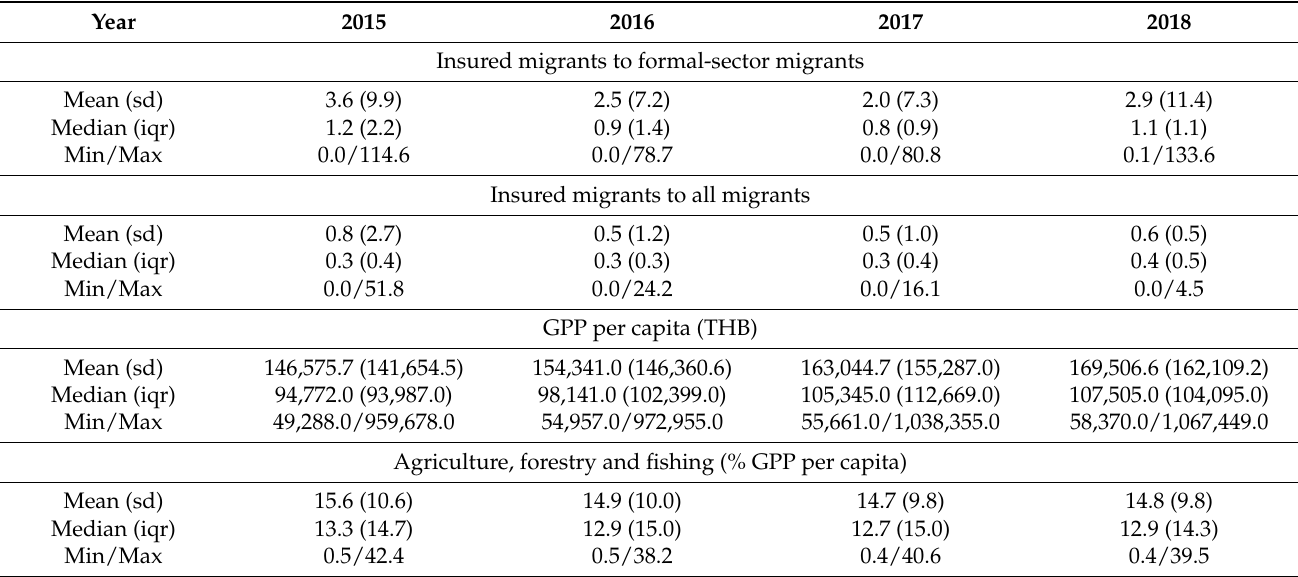
Table 2. Descriptive statistics of the dependent variables and the predictor variables at provincial level,